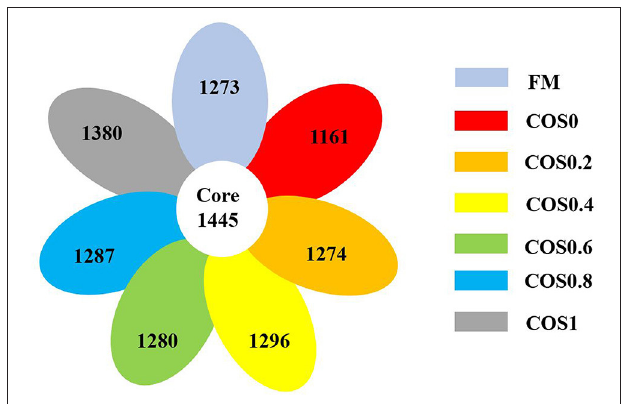
FIGURE 4 | Shared OTUs analysis of intestinal microbiota in hybrid grouper fed with experimental diets for 8 weeks.